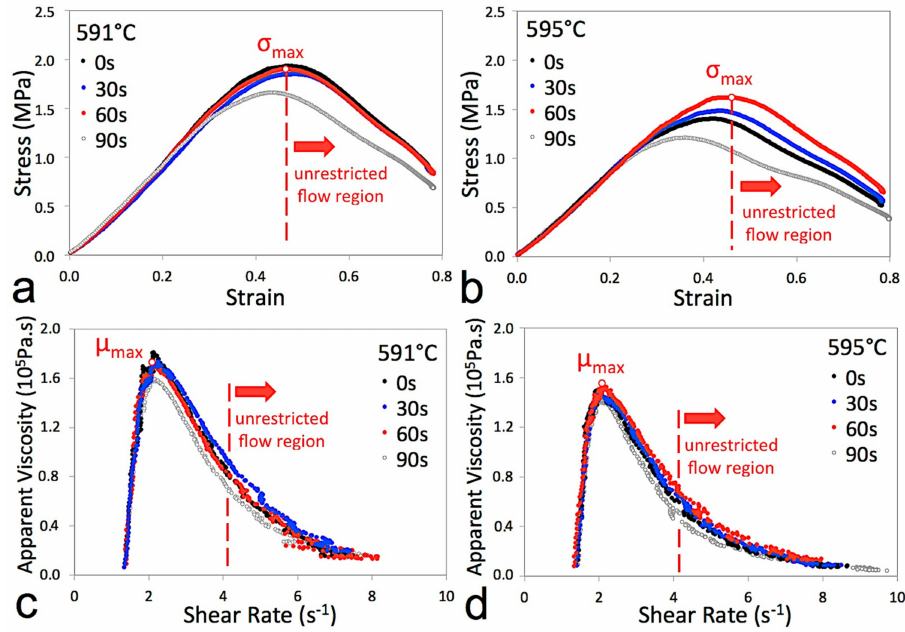
Figure 14. Engineering stress vs. engineering strain ( a , b ) and apparent viscosity vs. shear rate ( c , d ) curves measured during thixoforming (open-die forging) of B319+Fe alloy after heat treatment at 591 ◦ C and 595 ◦ C for 0, 30, 60, and 90 s. The maximum apparent viscosity, maximum stress, and unrestricted flow region are highlighted for a soak time of 60 s in all curves for illustrative